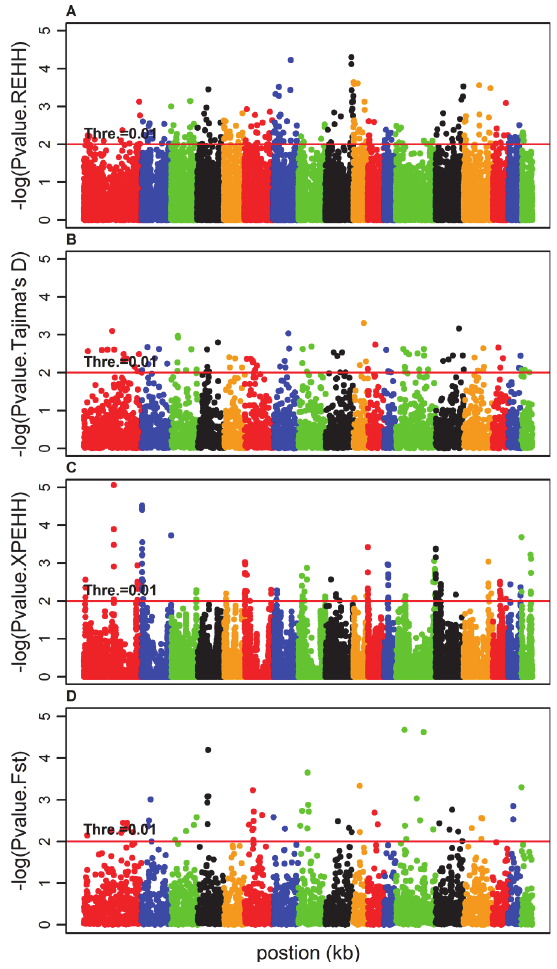
Figure 2. Genome-wide distribution of selection signatures detected by LRH, Tajima ’ s D, XPEHH and F ST cross all autosomes in